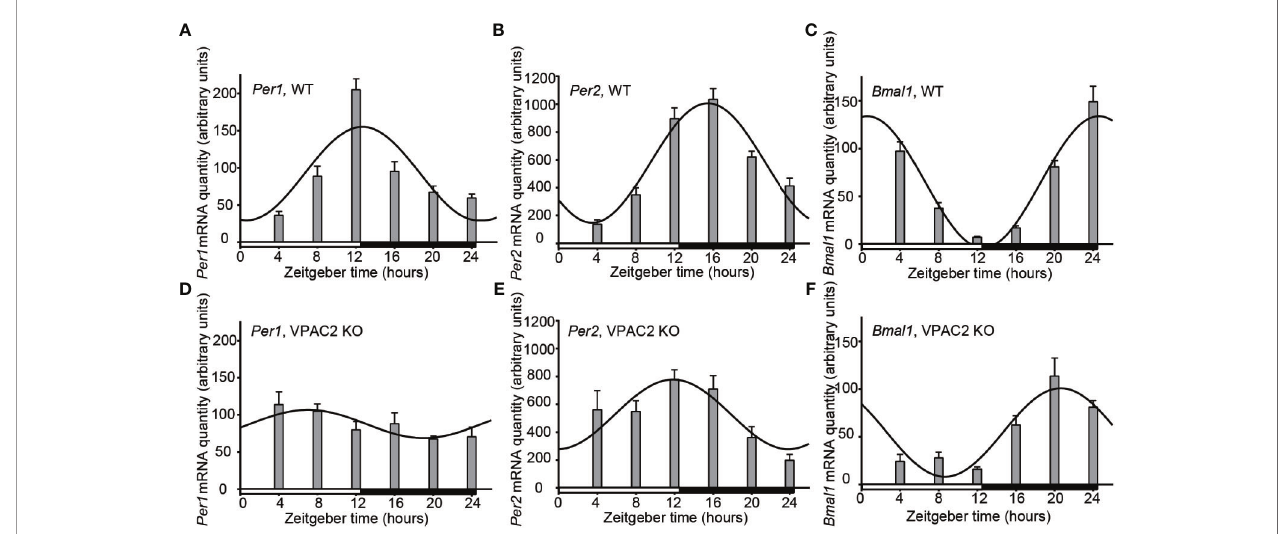
FIGURE 1 | Daily oscillation of clock gene mRNA in thyroid glands from wild-type (WT) and VPAC2 receptor knockout (KO) mice. RNA from thyroid glands of animals during 12:12 h light-dark cycles was extracted, and the amounts of Per1 (A, D) , Per2 (B, E) , and Bmal1 (C, F) mRNA were quanti fi ed by qPCR. b 2- microglobulin amounts were used for normalisation. The results are given as mean arbitrary units ± SEM, n = 8, and wild-type and KO animals are shown in (A – C) and D – F, respectively. In both groups of mice, the expression of all three clock genes displayed signi fi cant oscillations as a function of the 24 h LD-cycle (P < 0.001 for A – C, E, F , and P < 0.05 for D ). The curves show the 24 h cosinor fi ttings of the data. The white and black bars at the bottom of each graph represent the period of light and darkness during the tissue sampling period.